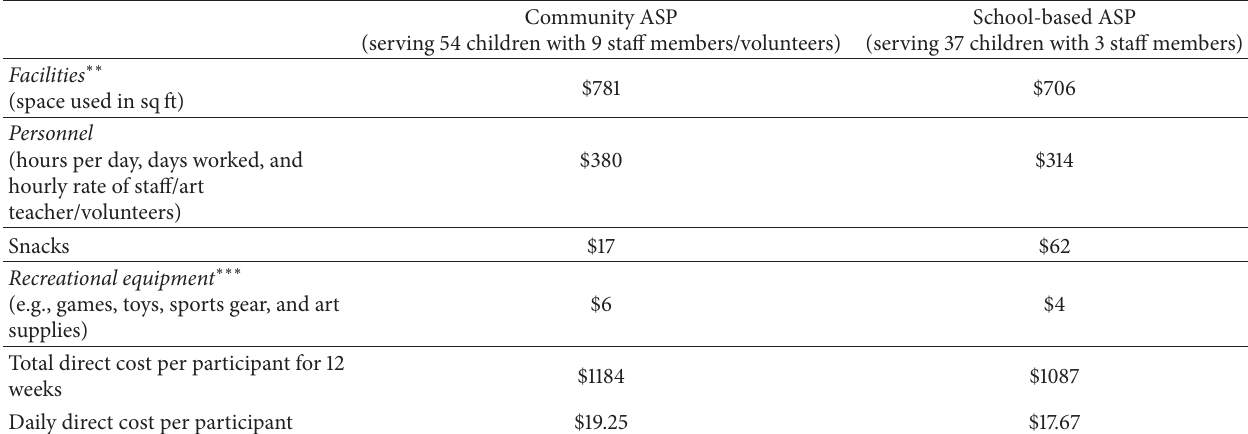
Table 4: Total implementation cost per participant and program (2010 dollars).